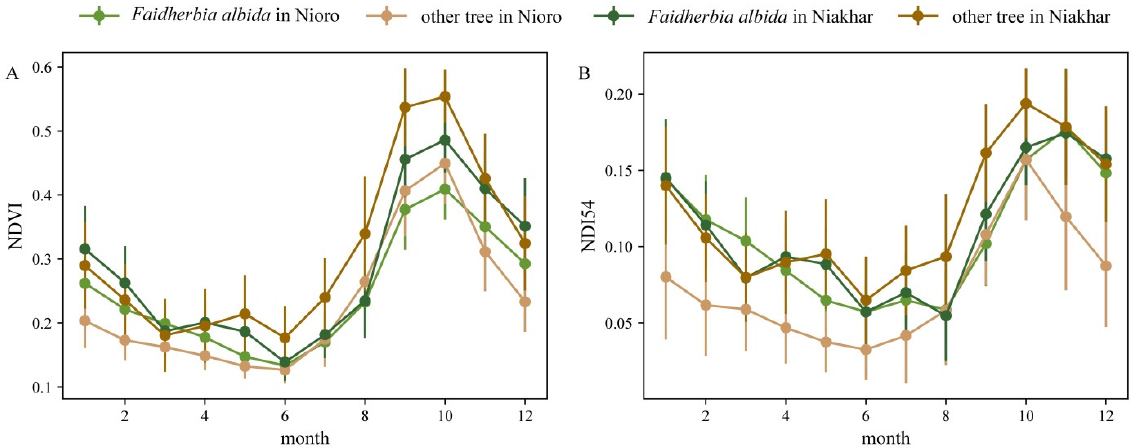
Figure 3. Averaged monthly ( A ) NDVI and ( B ) NDI54 values for sample pixels of Faidherbia albida and other species in the regions of Nioro and Niakhar. Vertical lines represent the standard deviation of the sample population. Overall, 1418 pixels were sampled and averaged over the study period, including 57 Faidherbia albida pixels and 112 pixels with other tree species in the Nioro region, and 459 Faidherbia albida pixels and 790 pixels with other species in the Niakhar region.